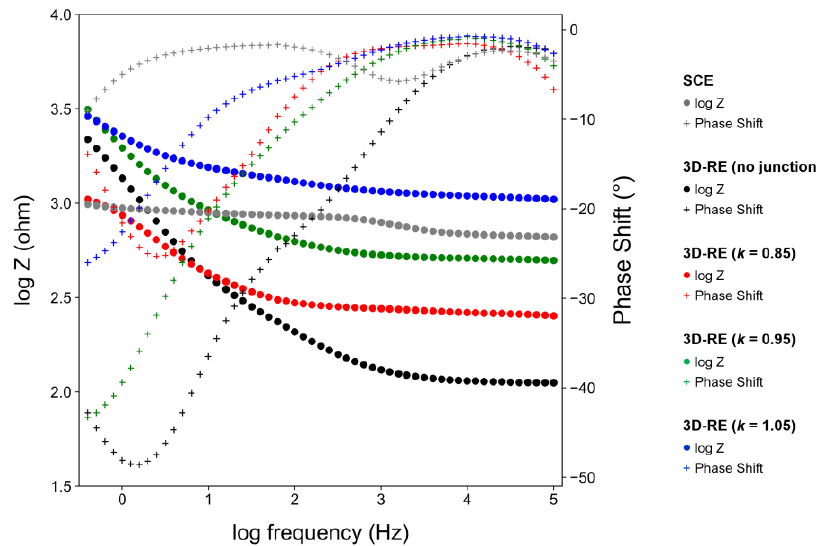
Figure 6. Bode plots of 3D-REs with 3D-printed junctions fabricated using variable extrusion ratios ( k = 0.85, 0.95, 1.05). For comparison, the Bode plots of a 3D-RE with no junction and a commercial SCE are also shown. Impedance spectra were recorded in 0.1 M KCl.